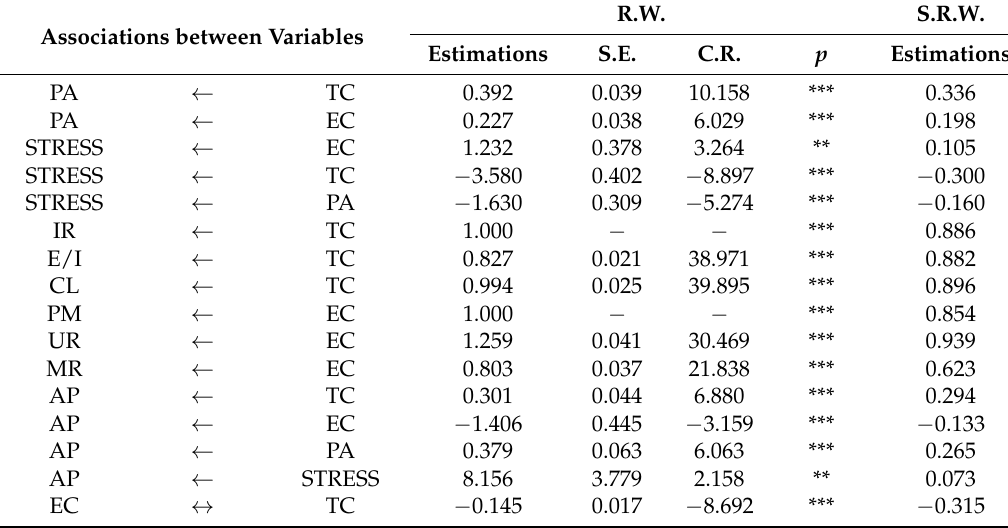
Table 1. Structural model for males. Associations between